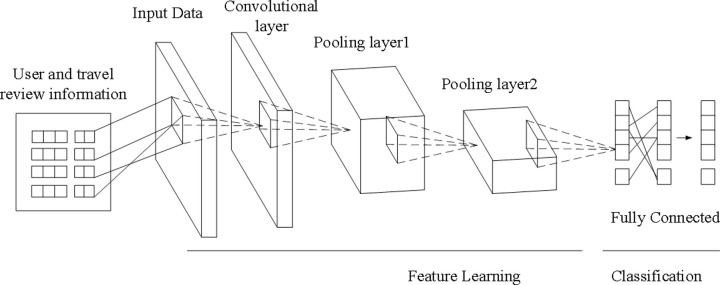
Deep prediction model framework.